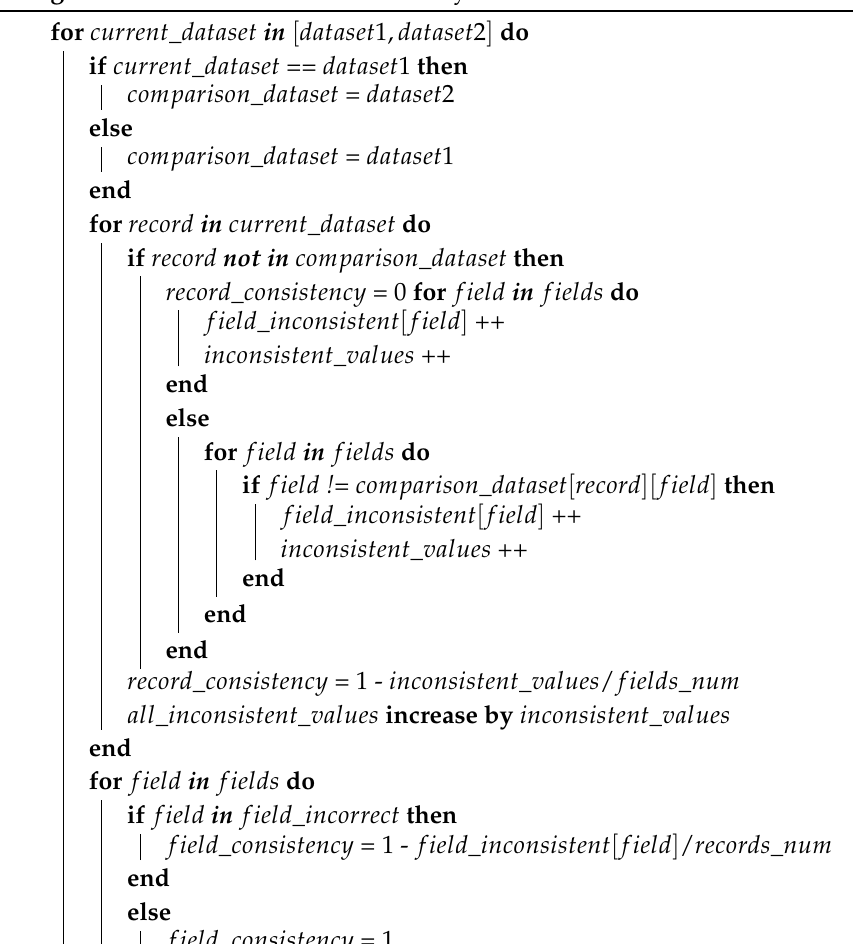
Algorithm 3: Pseudocode of consistency measurement for source